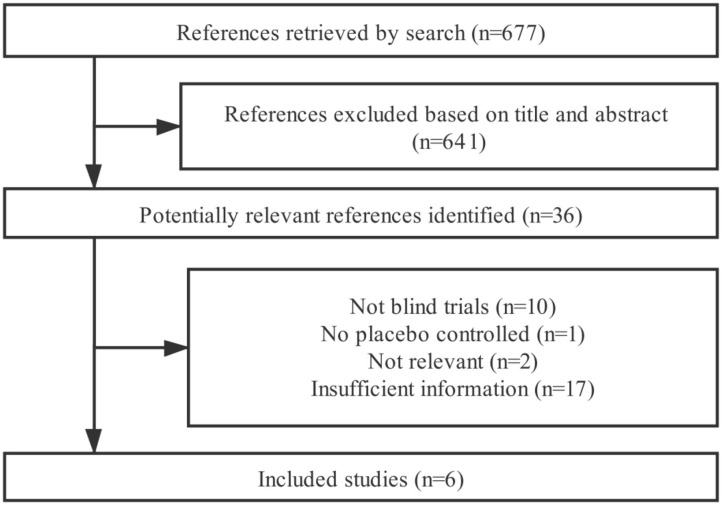
Flow chart of the meta-analysis.